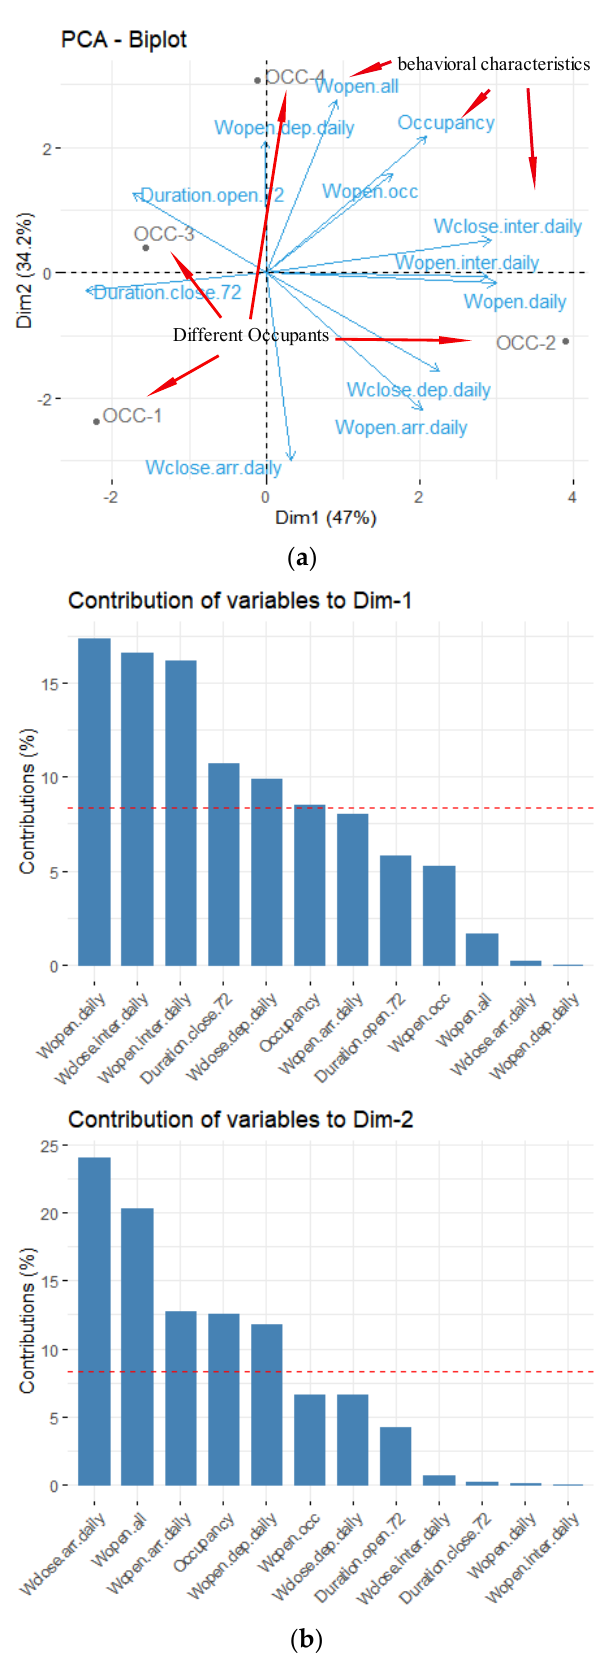
Figure 8. Principal component analysis to two-dimensional diagram. ( a ) Variable Correlation Plots. ( b ) Variable contributions to PC1 and PC2.